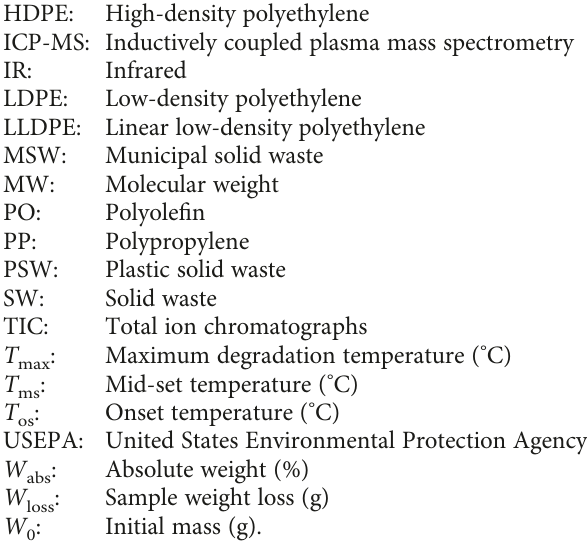
the evolved gases showing the second decomposition stage. Figure S10: total ion chromatographs of all samples including PE reference sample (virgin) and PE reference bag. Figure S11: thermogravimetric analysis (TGA) curve showing wt.(%) and fi rst derivative curve (DTG) with respect to temperature ( ° C) for type I post threshold limit accelerated weathering test. Figure S12: thermogravimetric analysis (TGA) curve showing wt.(%) and fi rst derivative curve (DTG) with respect to temperature ( ° C) for type II post threshold limit accelerated weathering test. Figure S13: thermogravimetric analysis (TGA) curve showing wt.(%) and fi rst derivative curve (DTG) with respect to temperature ( ° C) for type III post threshold limit accelerated weathering test. Figure S14: thermogravimetric analysis (TGA) curve showing wt.(%) and fi rst derivative curve (DTG) with respect to temperature ( ° C) for type I post 30 days of soil burial. Figure S15: thermogravimetric analysis (TGA) curve show- ing wt.(%) and fi rst derivative curve (DTG) with respect to temperature ( ° C) for type II post 30 days of soil burial. Figure S16: thermogravimetric analysis (TGA) curve show- ing wt.(%) and fi rst derivative curve (DTG) with respect to temperature ( ° C) for type III post 30 days of soil burial. Table S1: threshold limit of tested materials determined using accelerated weathering means. Table S2: crystallinity (%) estimated from second heating cycles for the soil burial samples. Table S3: crystallinity (%) estimated from second heating cycles for the accelerated weathering samples. Table S4: thermal stability and properties for the materials